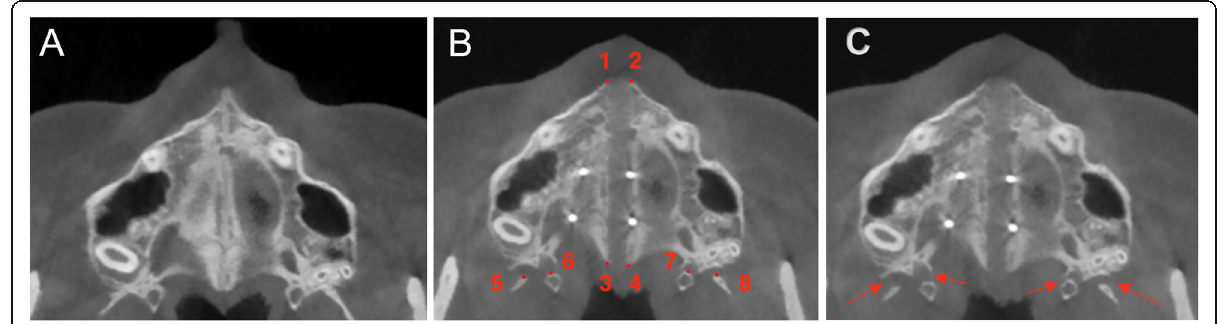
Fig. 7 a Pre-expansion view on axial palatal section. b Post-expansion view on axial palatal section showing anatomical landmarks. 1: right anterior nasal spine (ANS), 2: left anterior nasal spine (ANS), 3: right posterior nasal spine (PNS), 4: left posterior nasal spine (PNS), 5: the most anterior point of lateral plate of the right pterygoid process, 6: the most anterior point of medial plate of the right pterygoid process, 7: the most anterior point of medial plate of the left pterygoid process, and 8: the most anterior point of lateral plate of the left pterygoid process. c Disarticulation between medial and lateral pterygoid plates on both right and left pterygopalatine suture after